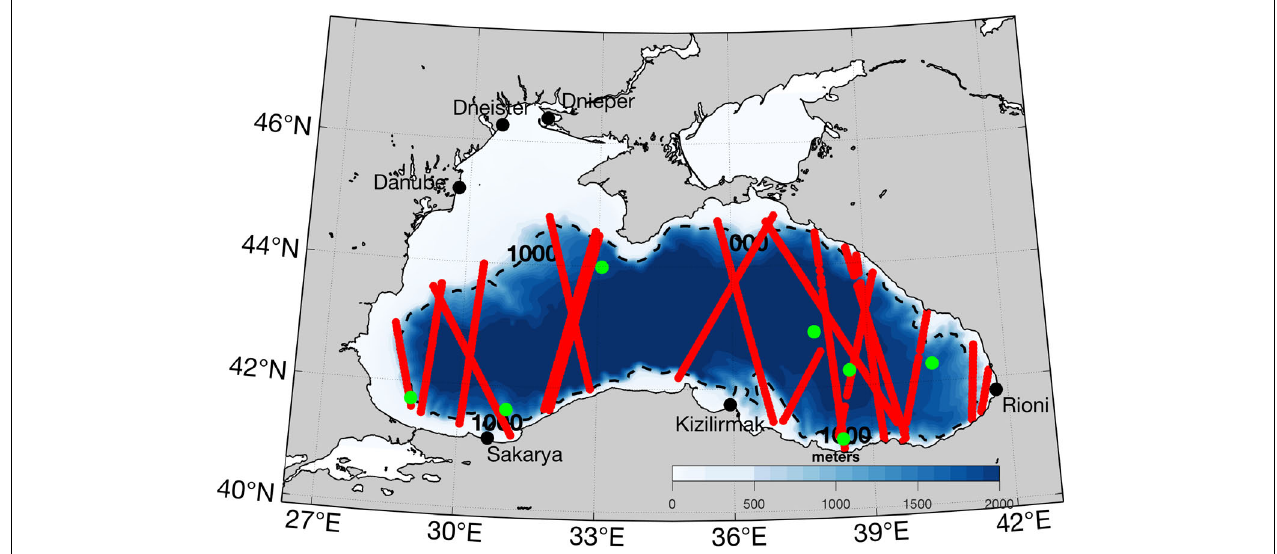
FIGURE 1 | Black Sea spatial domain and bathymetry. The red lines indicate the sea level anomaly along-track and green dots indicate the T and S in situ profiles available for data assimilation within the 4-day observation window on 18 October 2018.